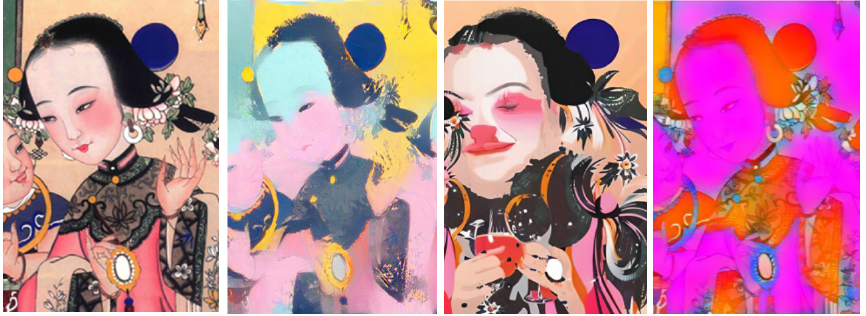
Figure 3. From left to right: original Yangliuqing New Year prints image; generated by “night café”; generated by “dream”; and generated by Vgg ‐ 19.